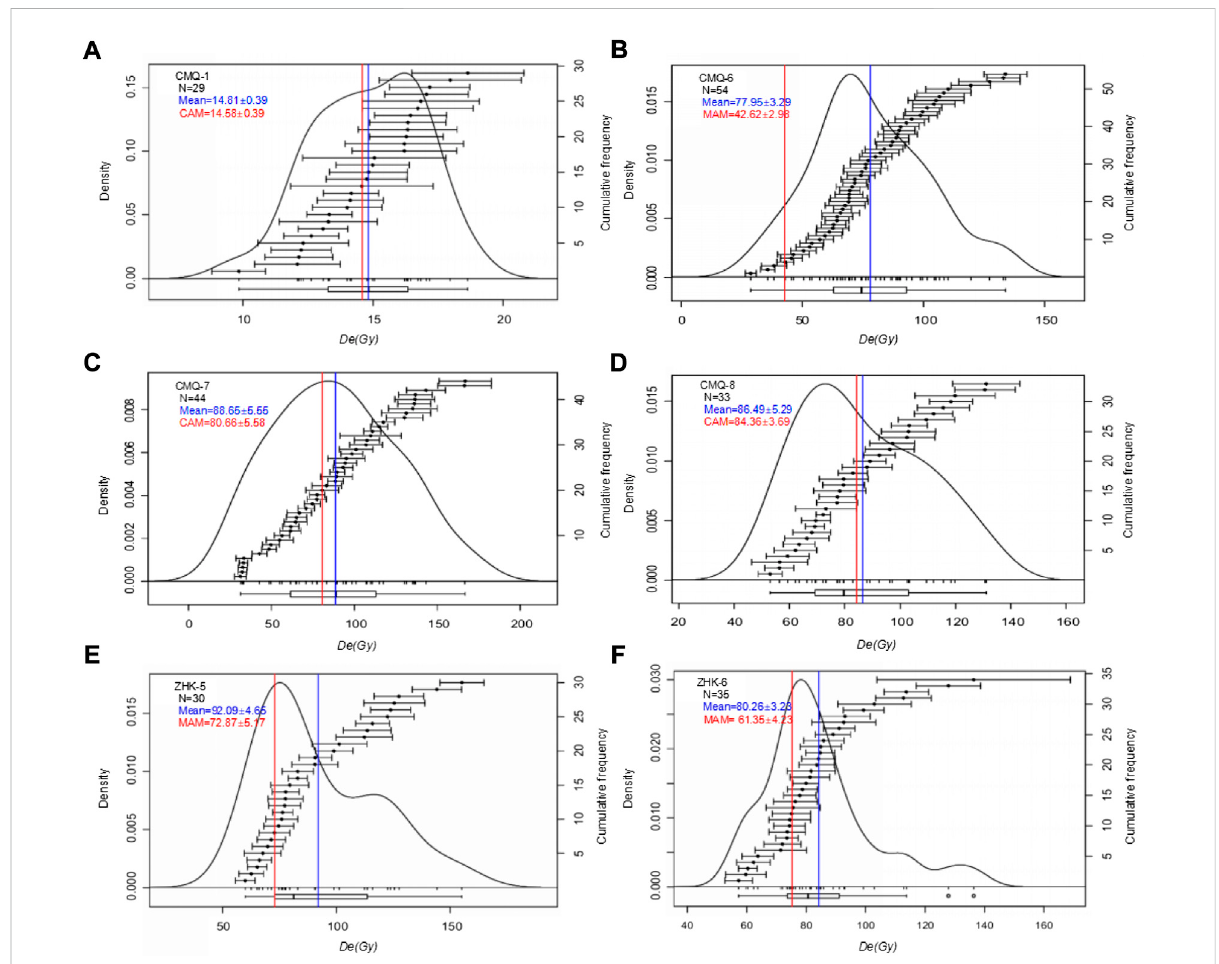
FIGURE 5 Plot_KDE() (KDE: kernel density estimates) for sample (A) CMQ-1, (B) CMQ-6, (C) CMQ-7, (D) CMQ-8 and (E) ZHK-5, (F) ZHK-6 from the CMQ and ZHK pro fi les in the Yellow River source area on the NE Tibetan